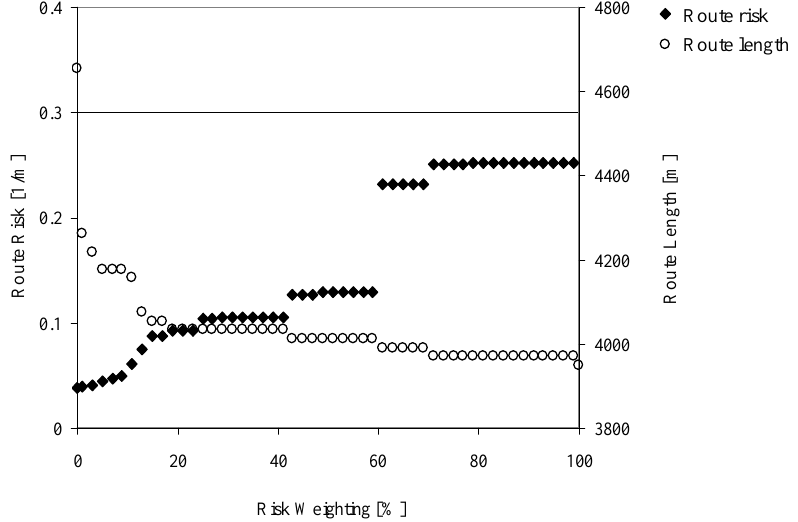
Figure 8: Route risk and route length versus risk weighting for the minefield in Figure